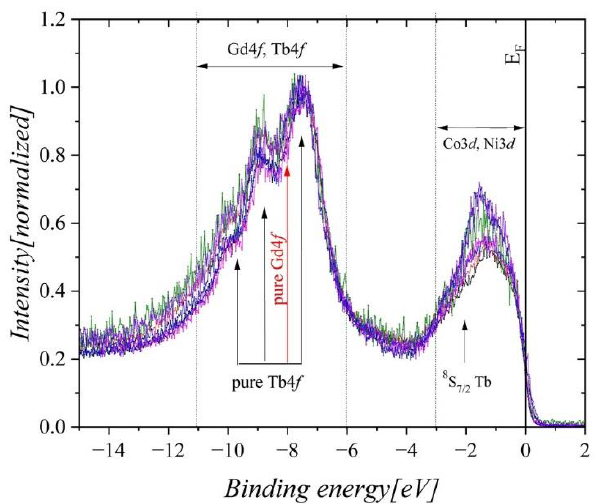
Figure 12. The XPS valence band of Gd 0 . 4 Tb 0 . 6 (Co 1x Ni x ) 2 . The spectra were normalized to the maximum intensity in this energy range. Vertical arrows show the positions of all spectral lines observed in elemental Gd, Tb, Co, and Ni.